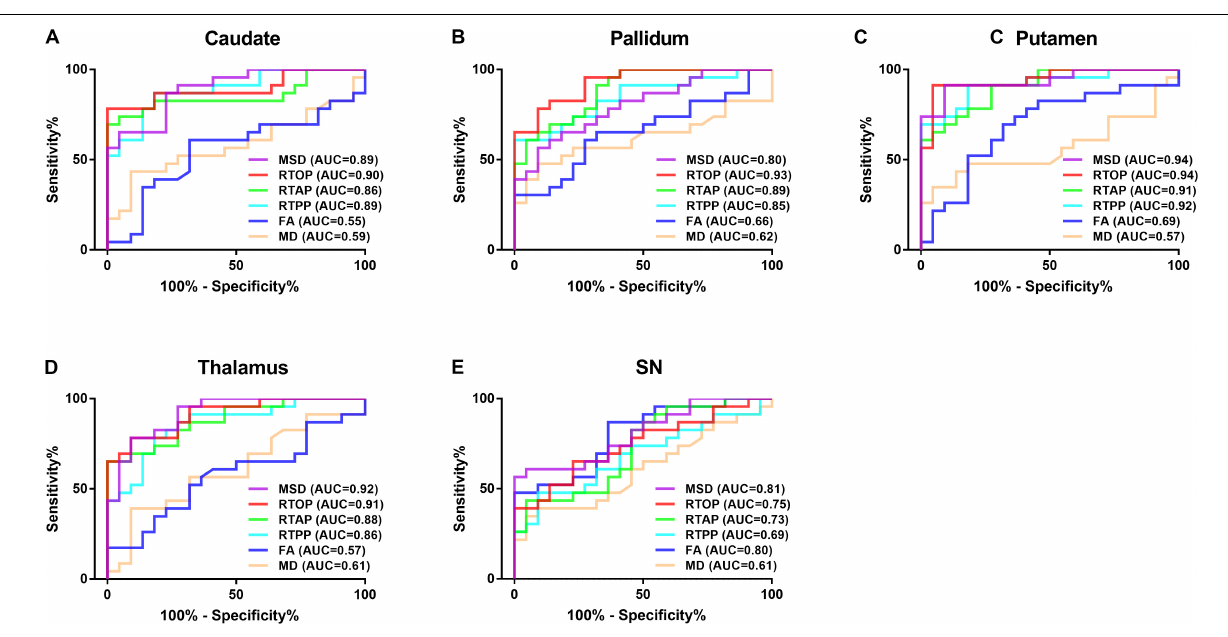
restricted diffusion components than MD (Ning et al.,